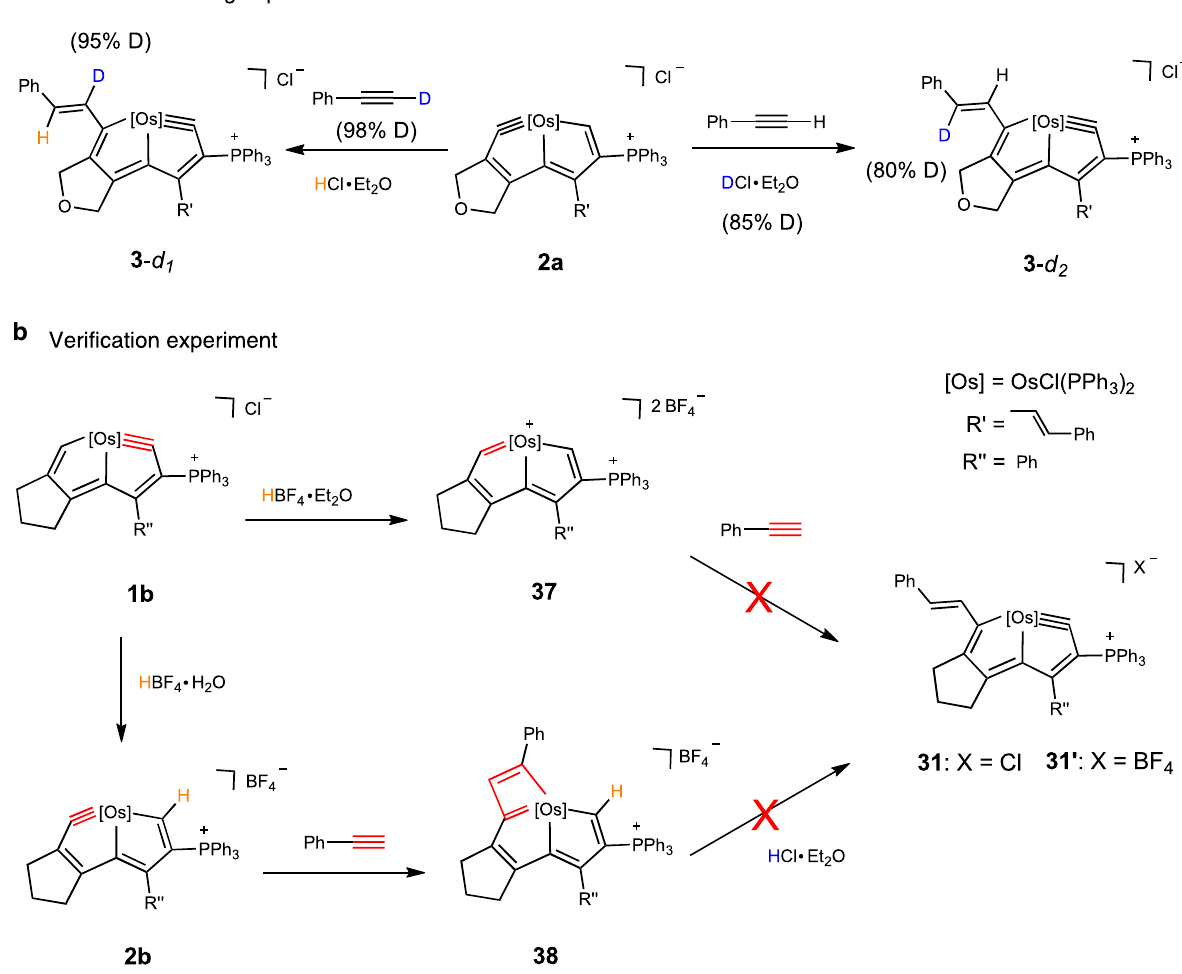
Fig. 2 Mechanistic studies. ( a ) isotope labeling NMR experiments and ( b ) veri fi cation